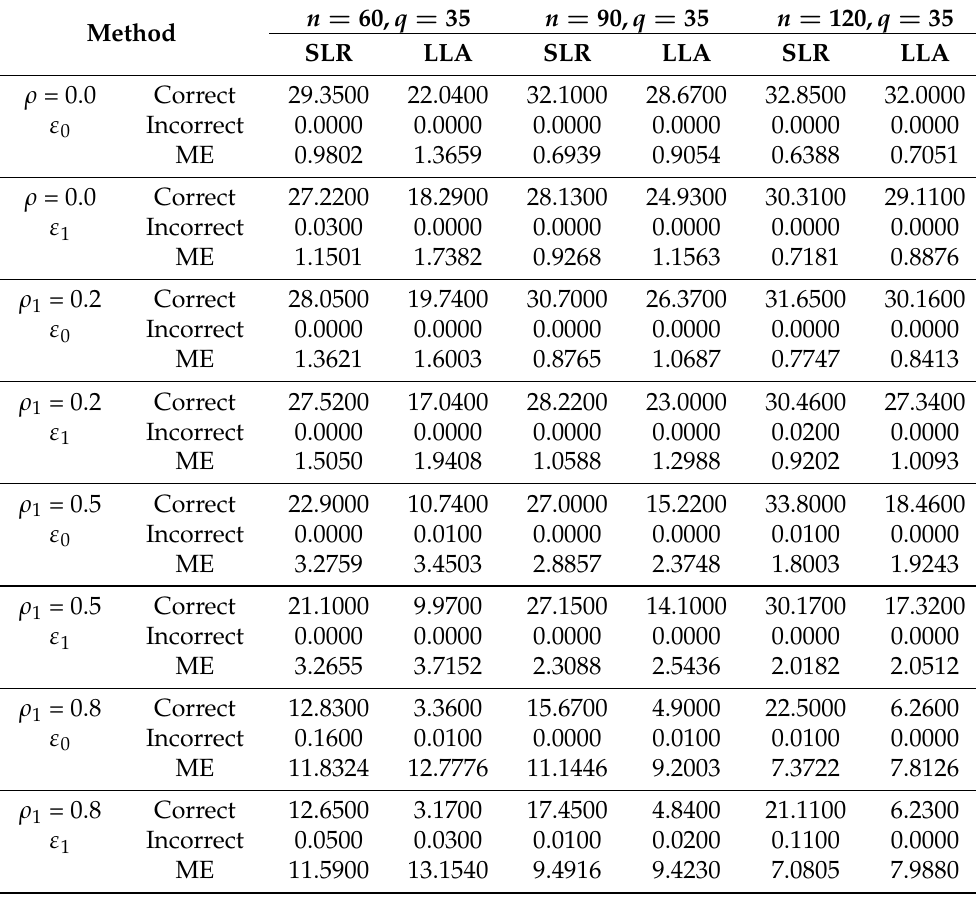
Table 3. Simulation results of variable selection via SCAD penalty function ( q = 35).